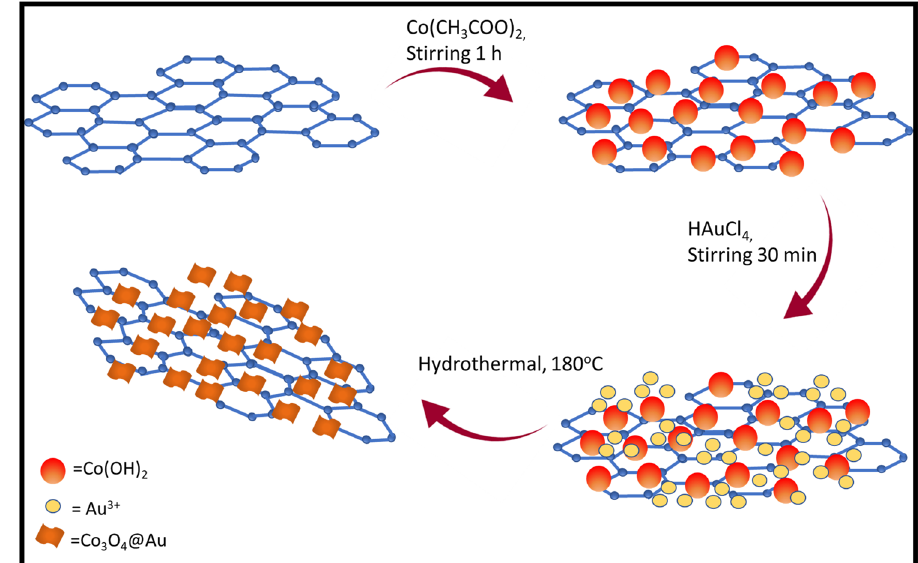
Figure 14: A schematic representation of functionalized graphene with Co 3 O 4 nanocubes and Au